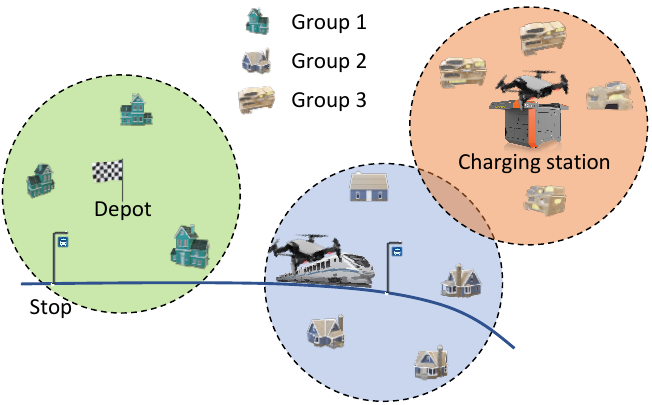
Figure 1. Illustration of the surveillance system and the grouping of sites based on their locations. The sites in the first group are located within a disk (in the ideal case) centred at the depot (green area). The sites in the second group are located within a disk centred at a vehicle stop (blue area). The sites in the third group are which are not covered by the first and second groups (orange area). A site located in the overlapping part of group two and group three can be reached by a UAV from a